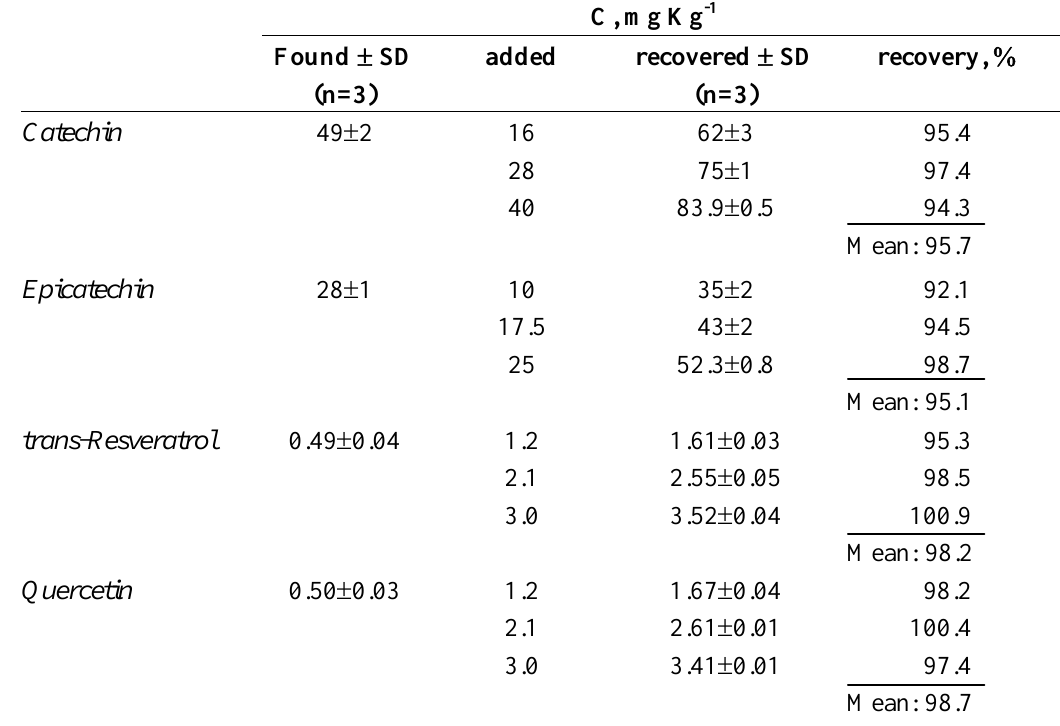
Table 3. Recoveries of the four phenolics from Savatiano variety grapes